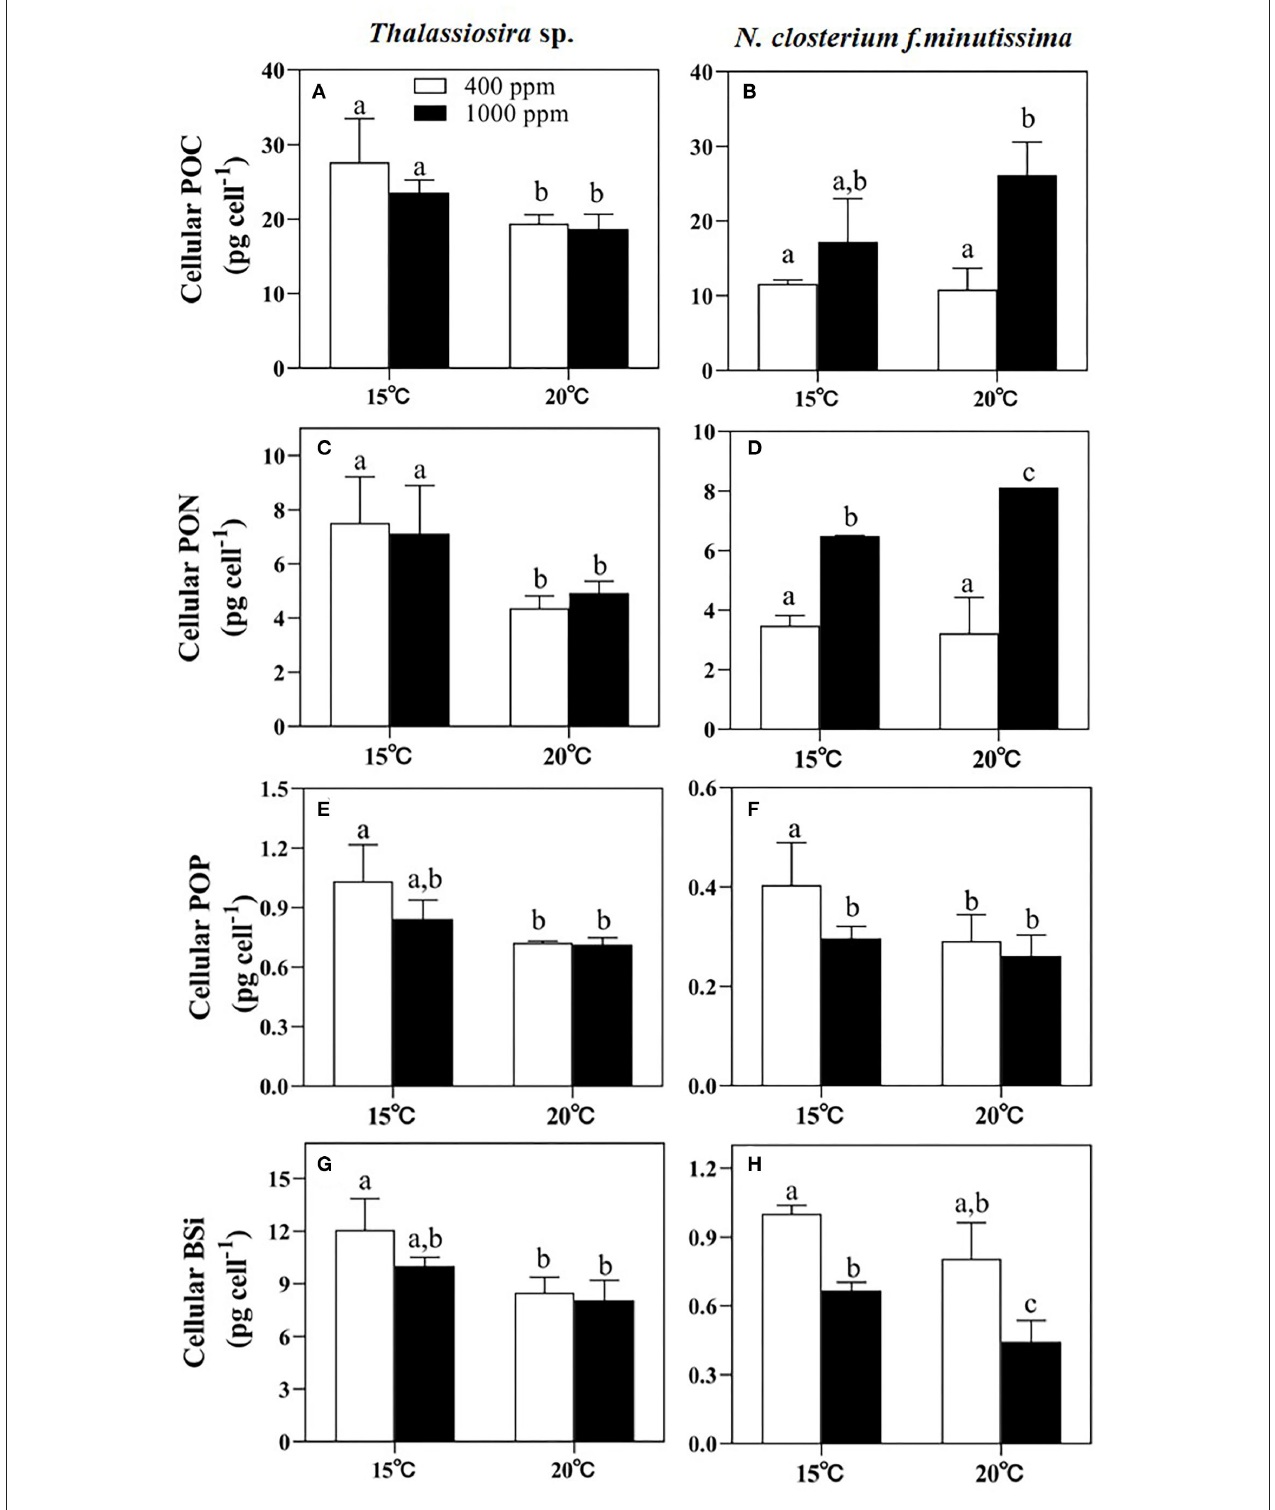
FIGURE 2 | The cellular POC, PON, POP, and BSi contents of Thalassiosira sp. (A,C,E,G) and N. closterium f.minutissima (B,D,F,H) under different pCO 2 and temperature interactions. The error bars represent standard deviations of triplicate samples. The letters above the bars denote the statistically significant differences. POC, particulate organic carbon; PON, particulate organic nitrogen; POP, particulate organic phosphate; BSi, biogenic silica.